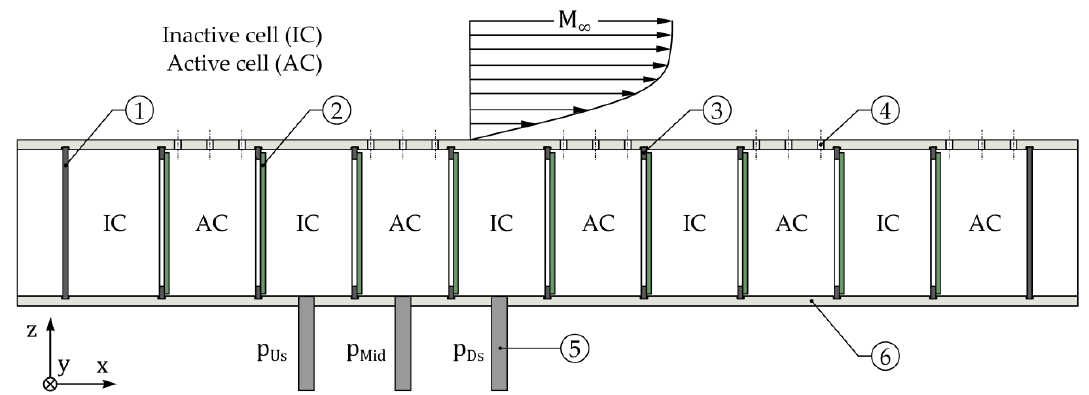
Figure 2. Unit cell of support structure square honeycomb (with cut-outs for flexible walls): ( a ) cross section view with face sheet and back plate; ( b ) three-dimensional view of square honey comb unit cell.